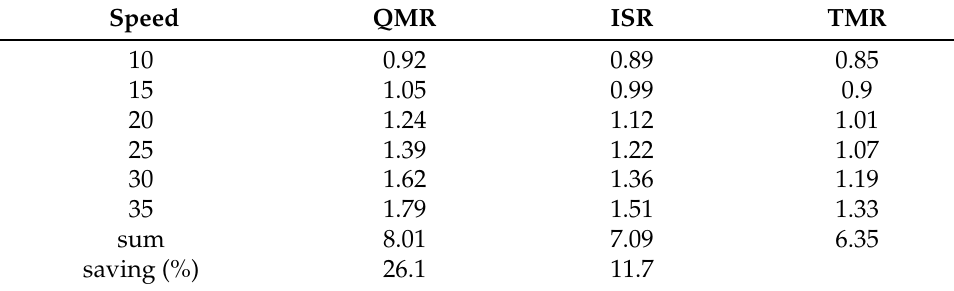
Figure 31. Comparison of QMR, ISR, and proposed protocol TMR for routing overhead with mobility speed. Table 6. Mobility speed vs. end-to-end delay of Figure